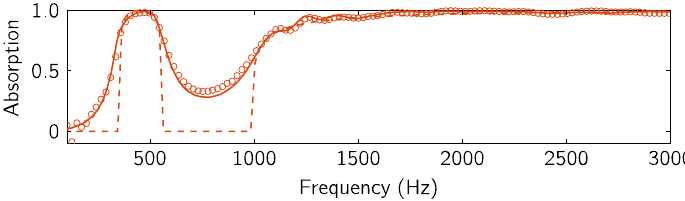
Figure 5. A designed absorption spectrum as indicated by the dashed line. The performance of the actual implementation with 16 FP resonators, with 3 mm of acoustic sponge on top, is shown by red circles. The red solid line is the theory prediction. It agrees very well with the experimental data as measured by the impedance tube.